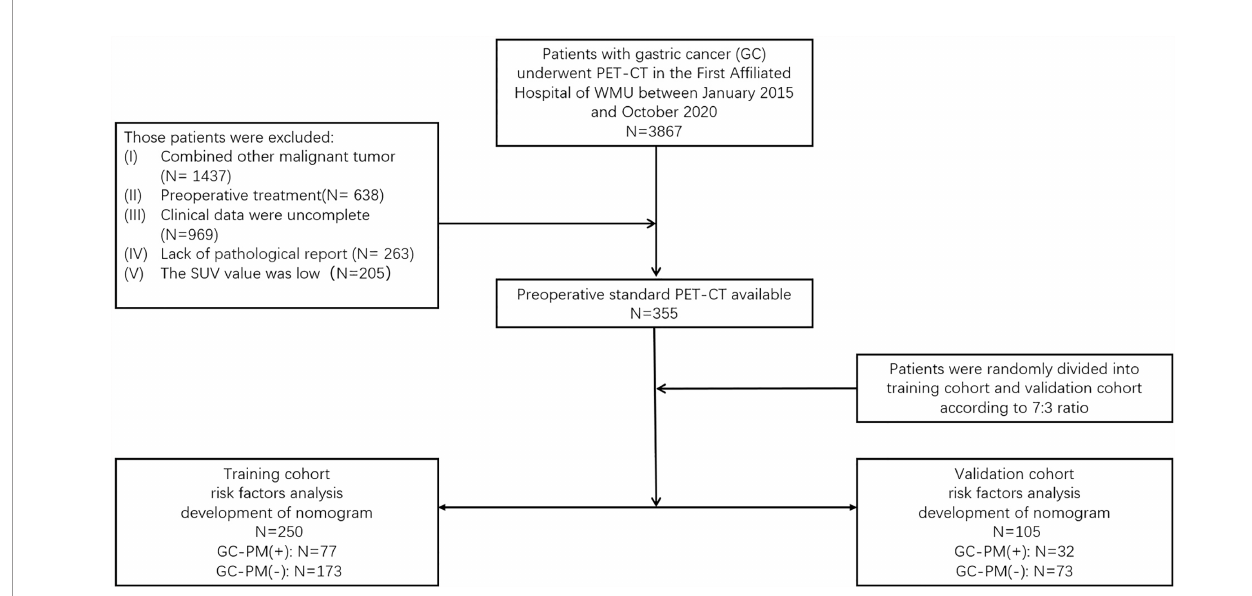
FIGURE 1 | Proceeding fl ow of enrollment.